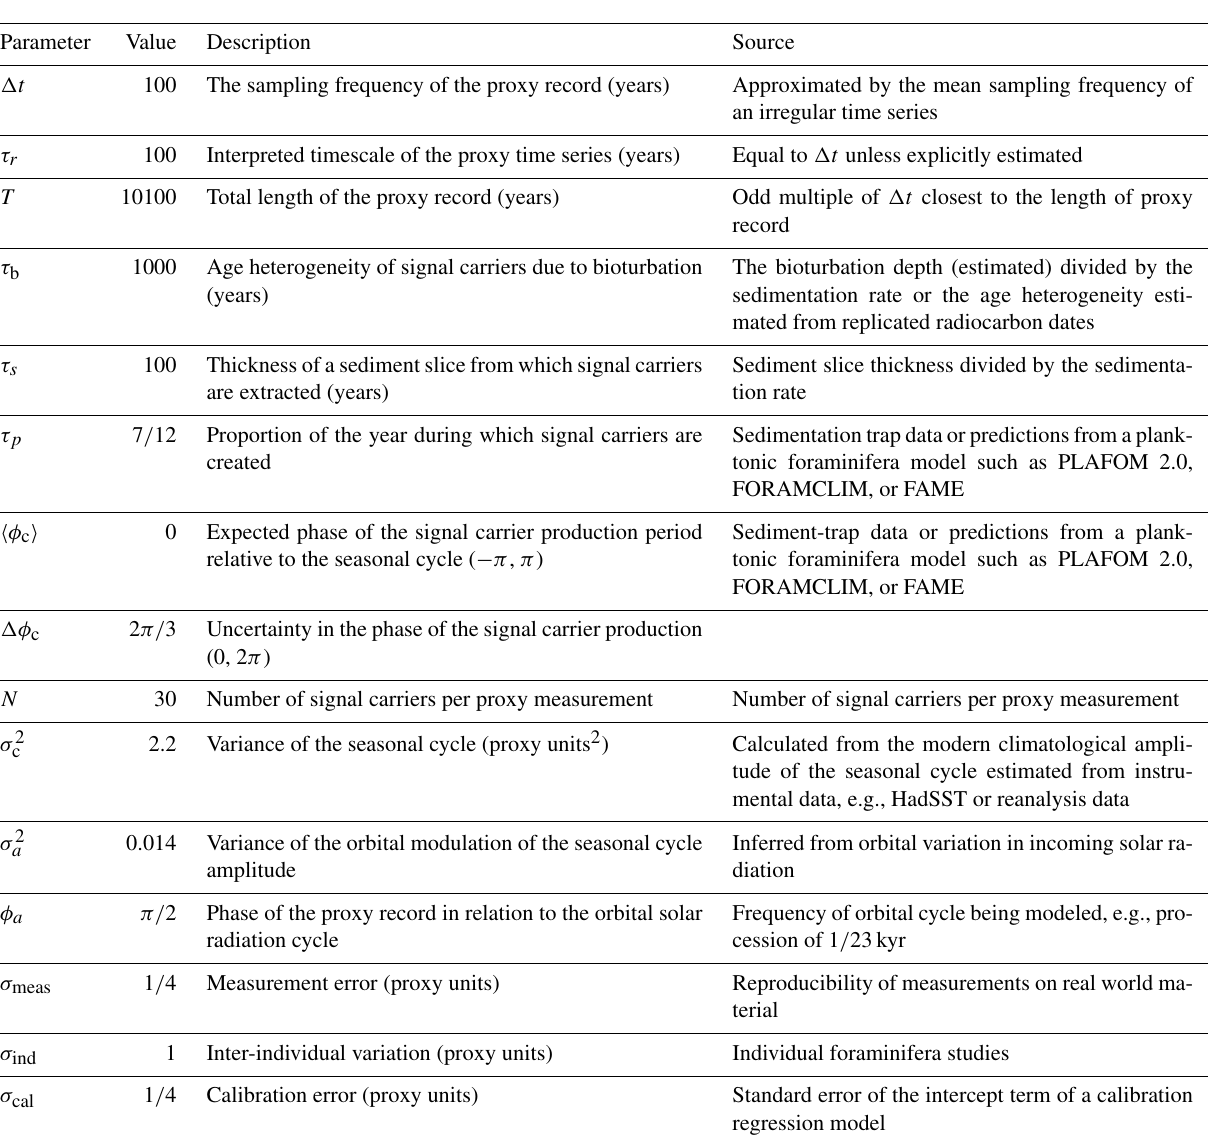
Table 1. Parameters required for the spectral error model with their values in example 1 plus possible sources. Parameter Value Description